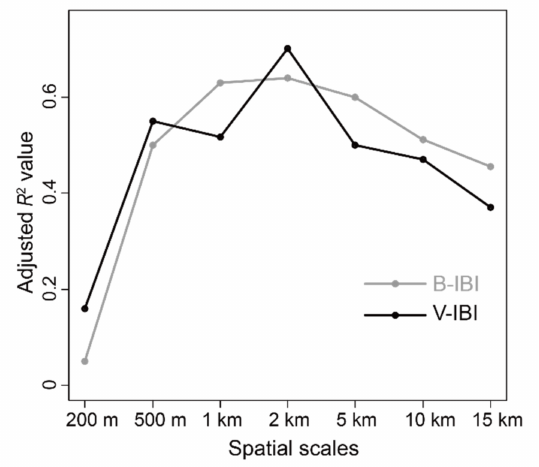
Figure 4. R 2 values of the most parsimonious multivariate linear models for benthic macroinvertebrate- (B-IBI) and vegetation-based (V-IBI) indices of biotic integrity using landscape and remote sensing metrics in different buffer zones of sample sites as the explanatory